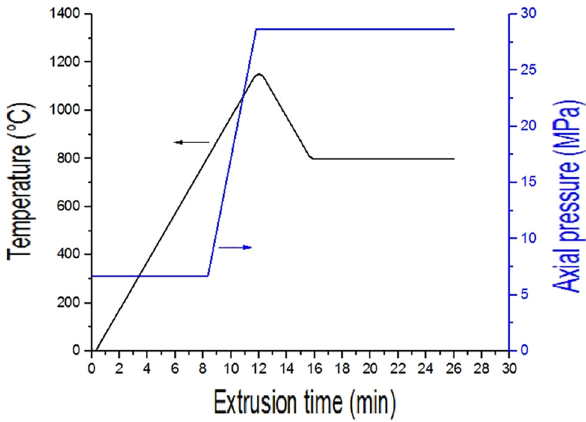
Figure 2: Heating program and loading pro fi le used to conduct the SPE of HA